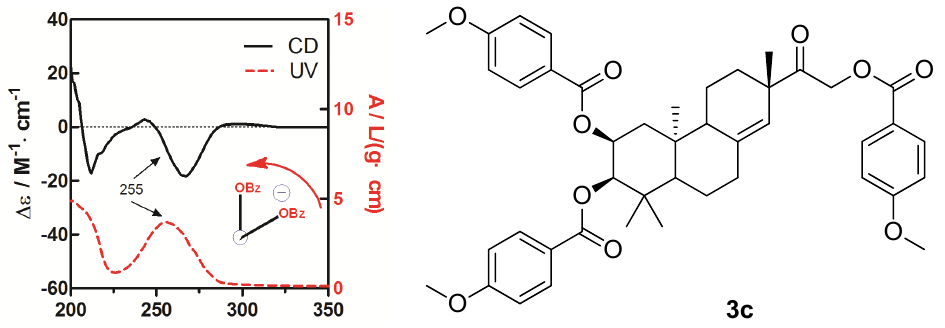
Figure 5. CD and UV spectra of compound 3c in MeOH. The arrow denotes the electric transition dipole of the chromophores.